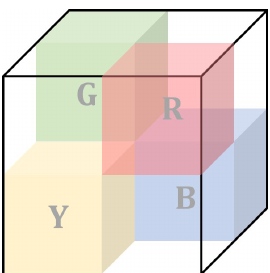
Figure 6: A 2 × 2 × 2 cell of the checkerboard cubic lattice. Shaded (empty) cubes belong to the A ( B ) sublattice of the checkerboard bipartition. The A is further par- titioned by a four-coloring into { r,g,b,y }